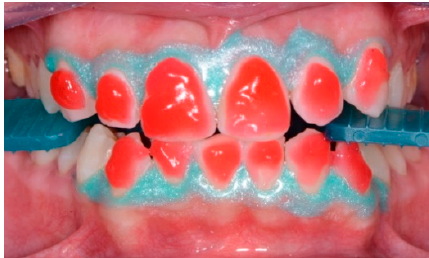
Figure 14. Bleaching of the upper and lower teeth with esthetic relevance.